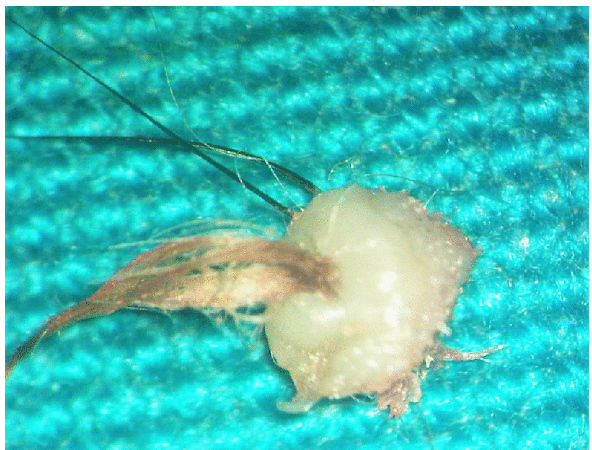
Figure 2: Clinical photograph of the specimen after